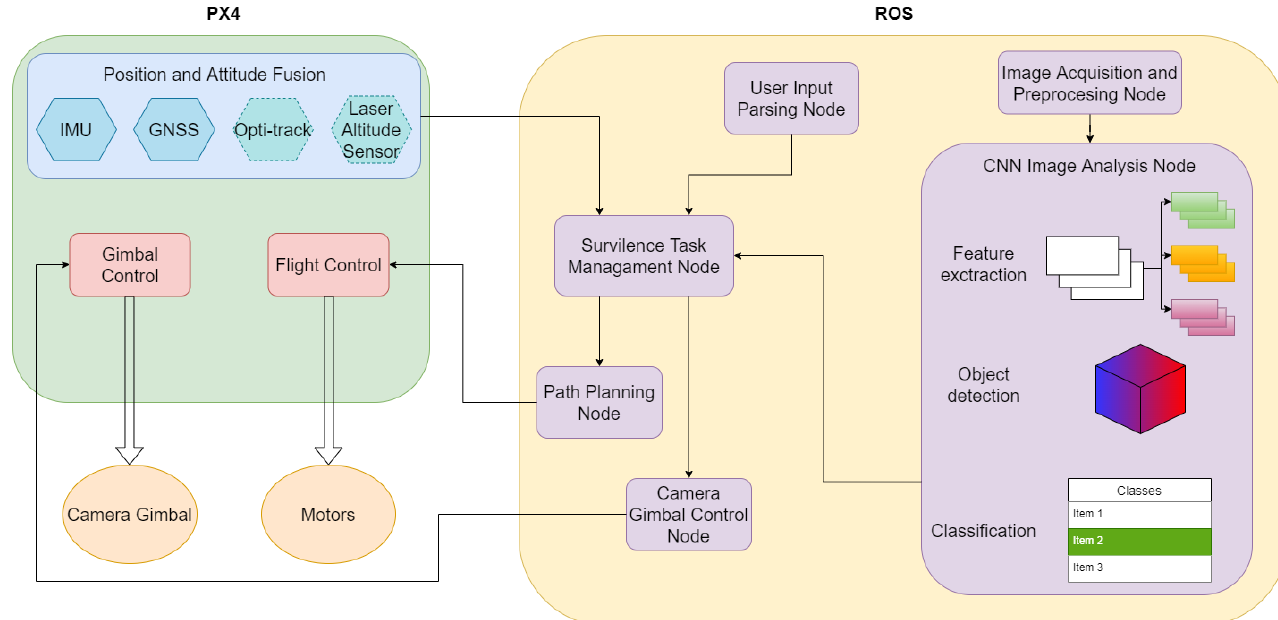
Figure 1. Quadrotor UAV used in the studies and during IMAV competitions.